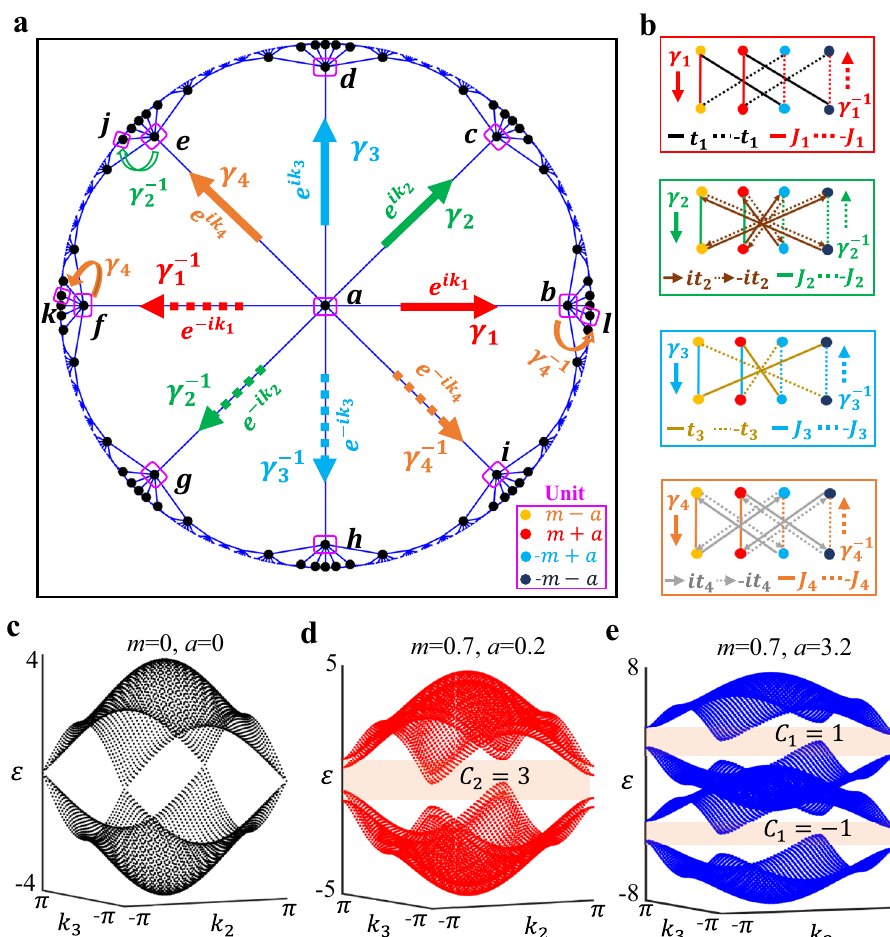
Fig. 1 | The tight-binding lattice model in 2D hyperbolic space with second Chern numbers. a The Bravais lattice {8,8} of proposed hyperbolic models in a Poincaré disk. The translation group of the designed hyperbolic model is a Fuch- siangroupde fi nedby Γ f 8,8 g = < γ 1 , γ 2 , γ 3 , γ 4 , γ (cid:1) 1 1 , γ (cid:1) 1 2 , γ (cid:1) 1 3 , γ (cid:1) 1 4 : γ 1 γ (cid:1) 1 2 γ 3 γ (cid:1) 1 4 γ (cid:1) 1 1 γ 2 γ (cid:1) 1 3 γ 4 >, where γ 1 to γ (cid:1) 1 4 manifest group generators of the hyperbolic Bravais lattice in a Poincaré disk and are marked by eight colored arrows. Dots fi lled with different colors in the bottom inset illustrate four sublattices in a single unit and the cor- responding onsite potentials equal to m − a, m + a, − m + a, − m − a , respectively.